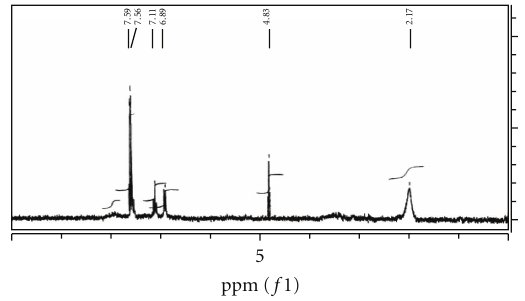
Figure 3: 1 HNMR of L II H spectrum in CD 2 Cl 2